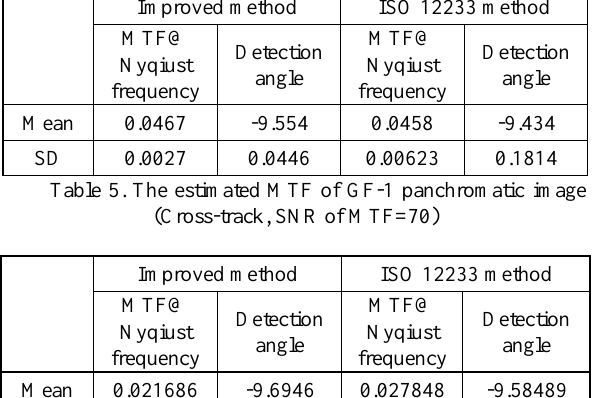
Figure 18. KOMPSAT-5 SAR resolution assessment result PLSR is ratio of the intensity of the most intense peak of the IRF in the side lobe to the peak intensity in the main lobe. PLSR assessment result is shown in Figure 19. The nominal PLSR is -19dB.